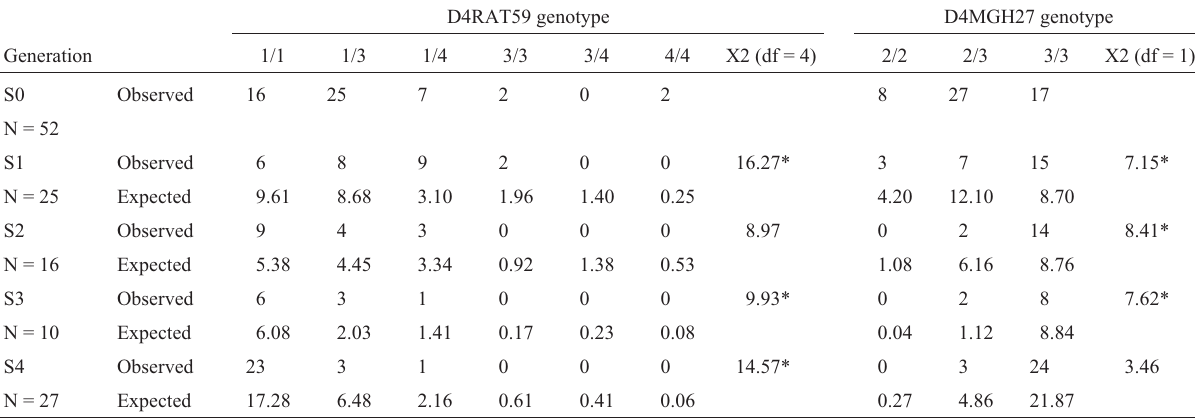
Table 2 - Total number of individuals per genotype class and chi-square for Hardy-Weinberg equilibrium, for each generation of Floripa H rats, in rela- tion to two markers for the QTL Ofil1